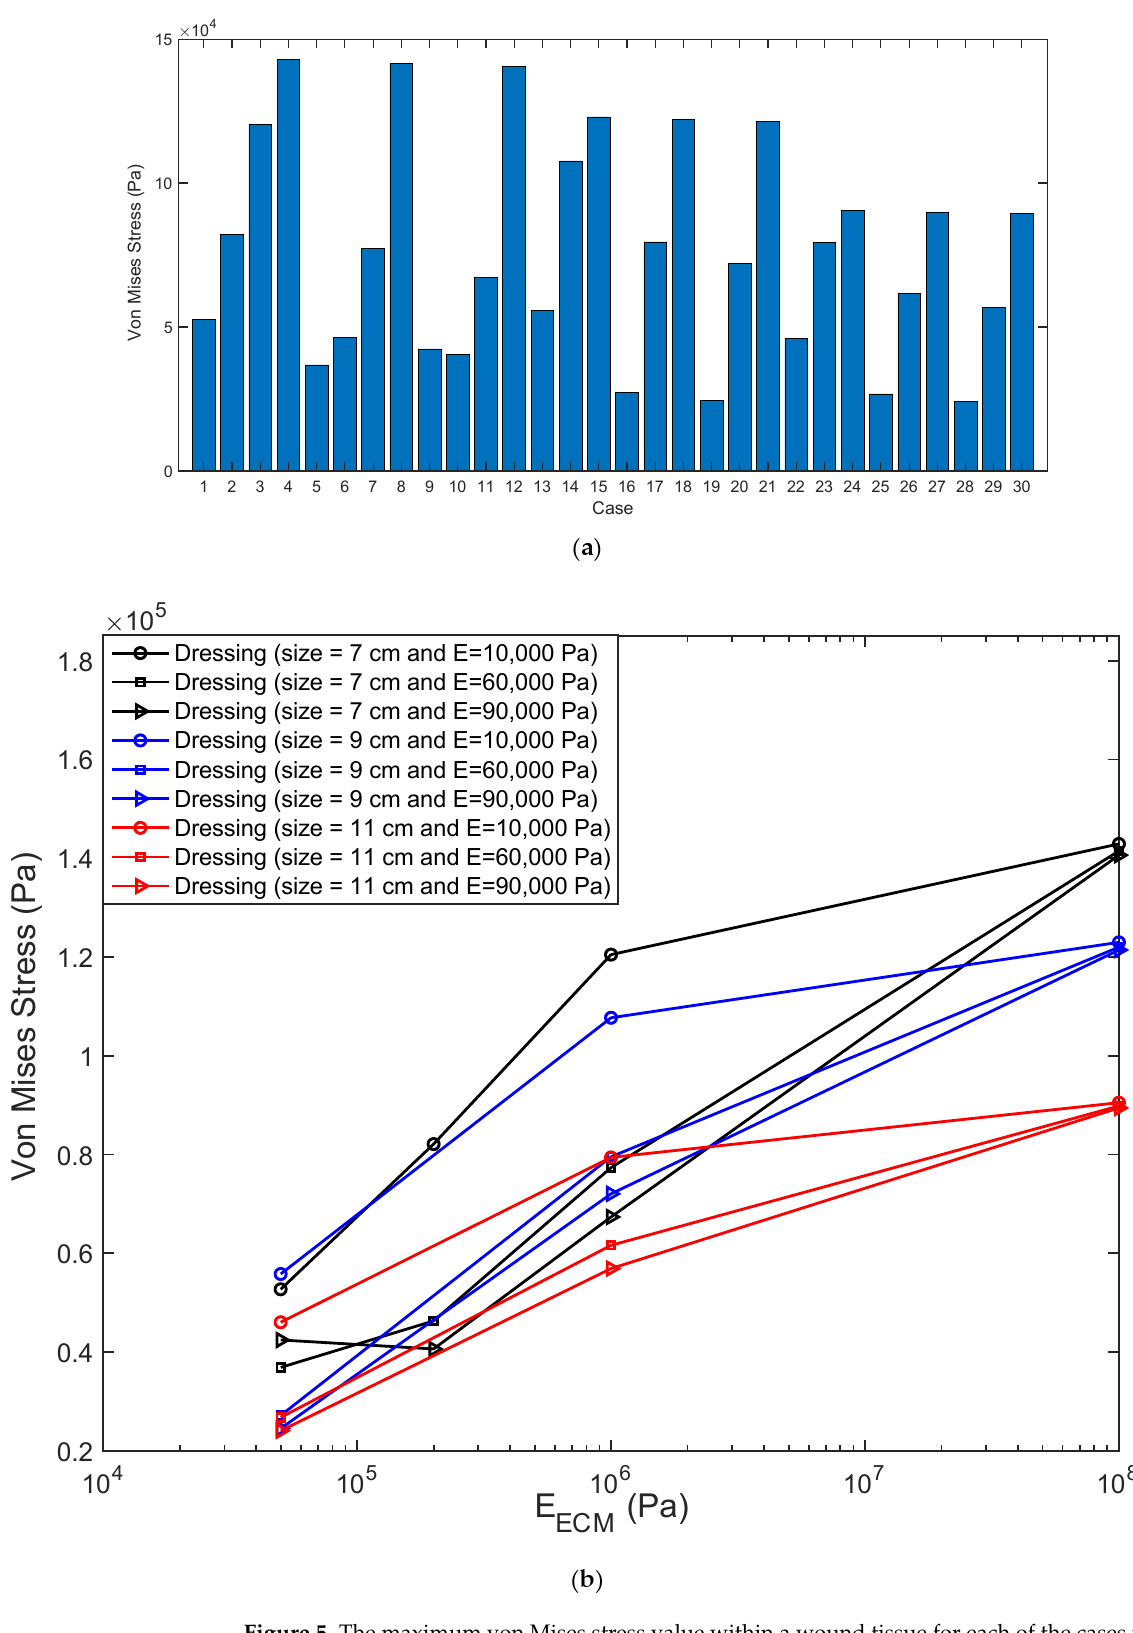
Figure 5. The maximum von Mises stress value within a wound tissue for each of the cases in Table 1. ( A ) Shown as histogram, ( B ) The maximum of von Mises stress within a wound tissue, treated by different dressings, is plotted against wound tissue ‘s stiffness.